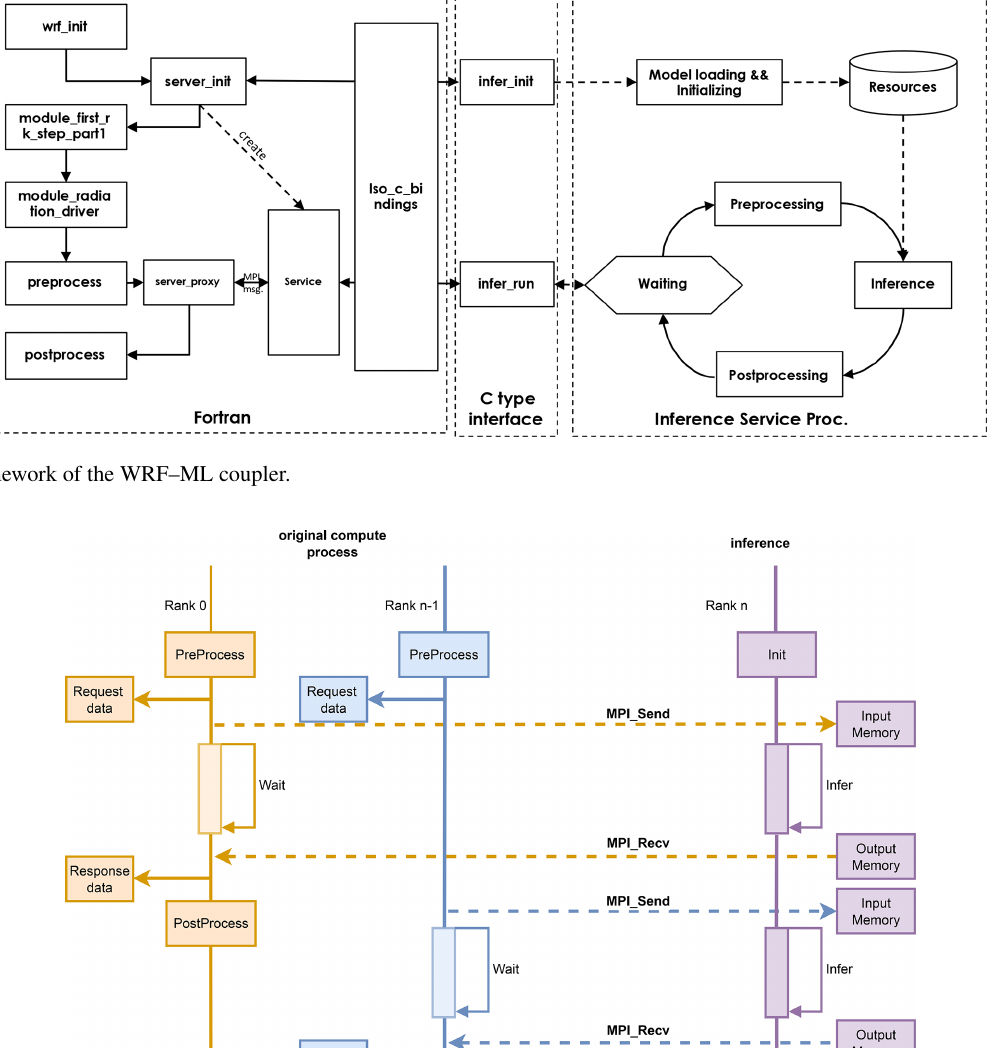
crucial for applying ML models in operational NWP